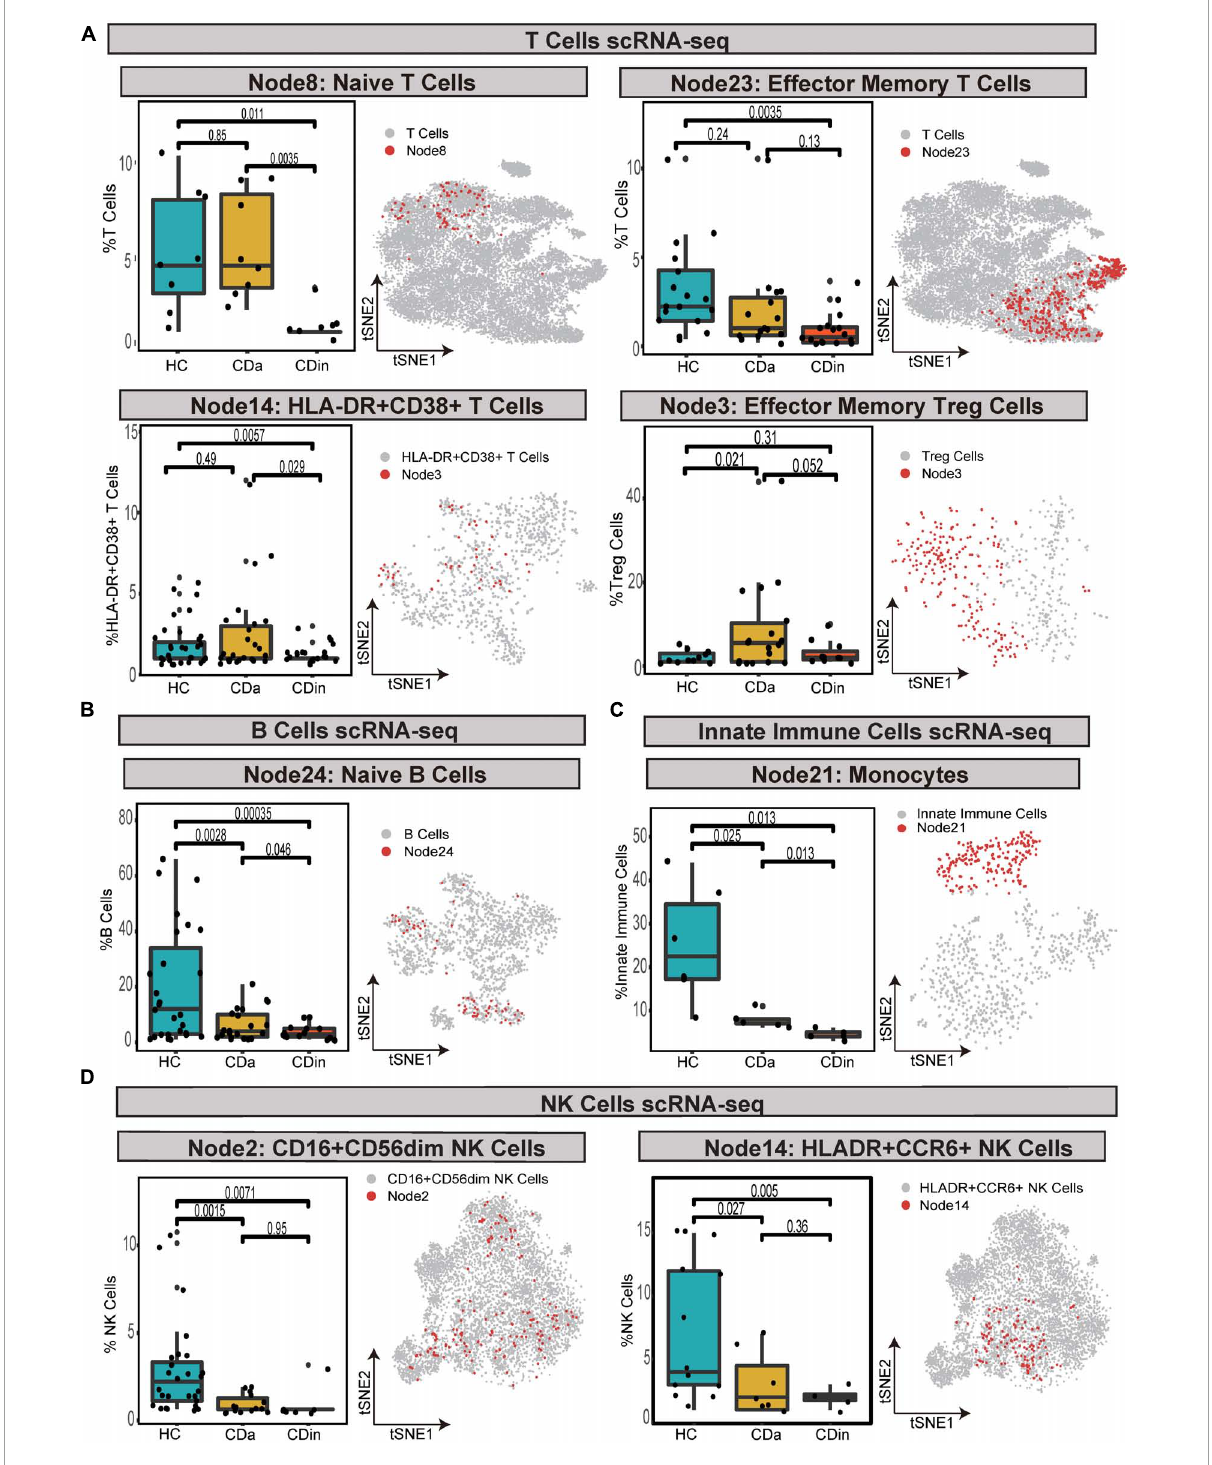
FIGURE8 Validation of cell subsets differences between CD and HC by scRNA-seq. (A–D) Box plots of T-cell subsets (A) , B-cell subset (B) , an innate immune cells subset (C) , and NK cell subsets (D) abundances among CDa, CDin, and HC are shown on the left, with Wilcoxon rank-sum test results. t-SNE plots depicting the distribution of various cell subsets are shown on the right, respectively. The “Node” labels in the box plot and the t-SNE plot correspond to the CyTOF